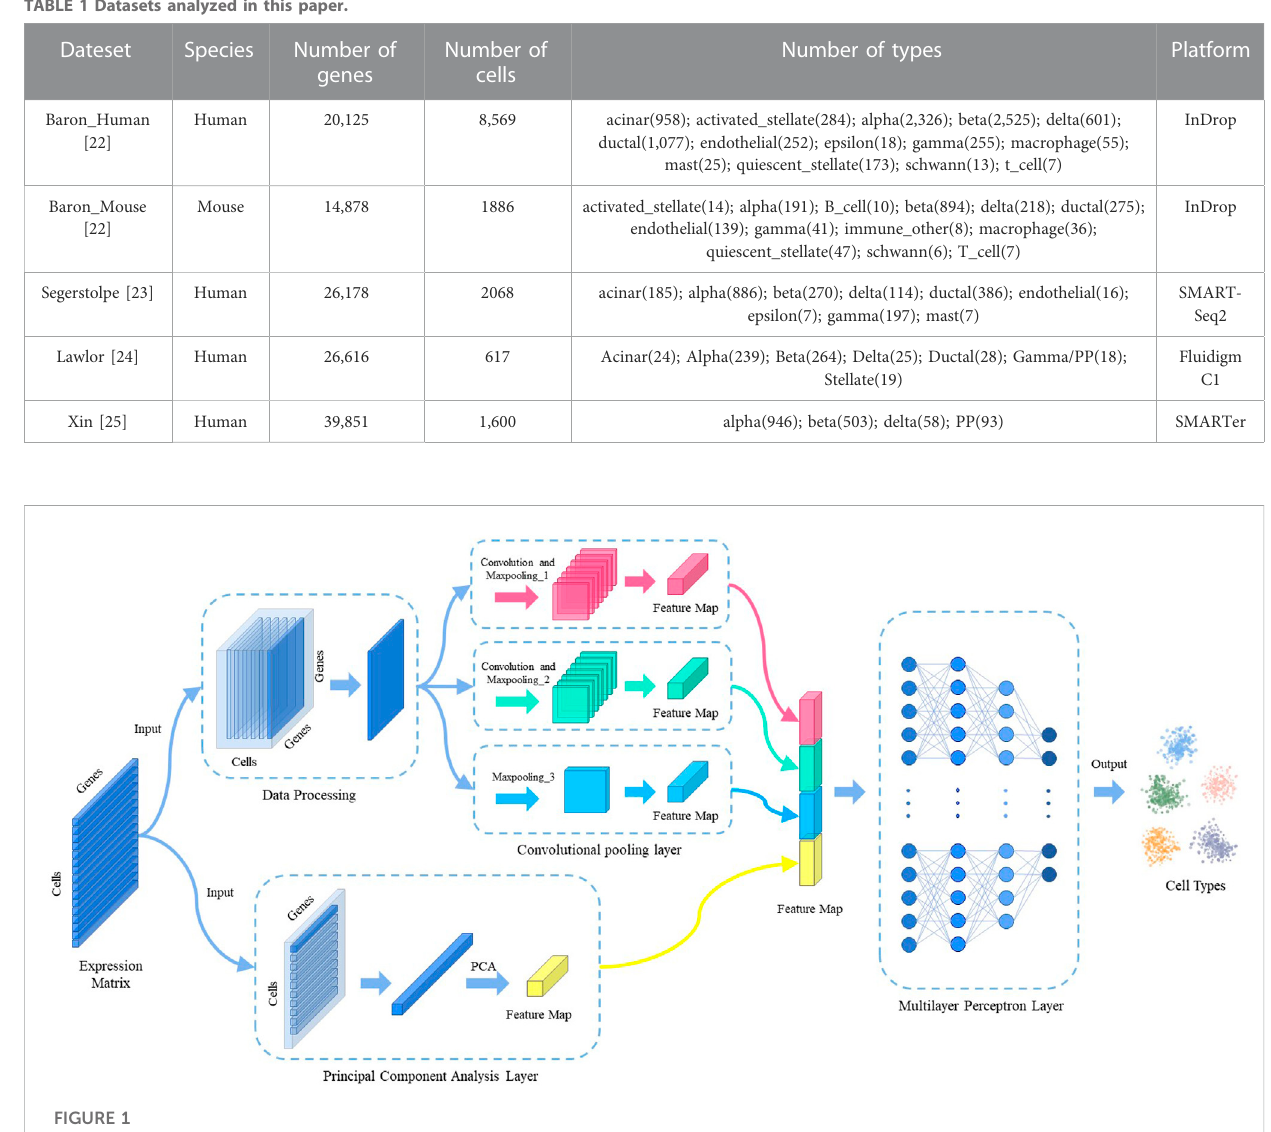
FIGURE 1 The overall architecture of